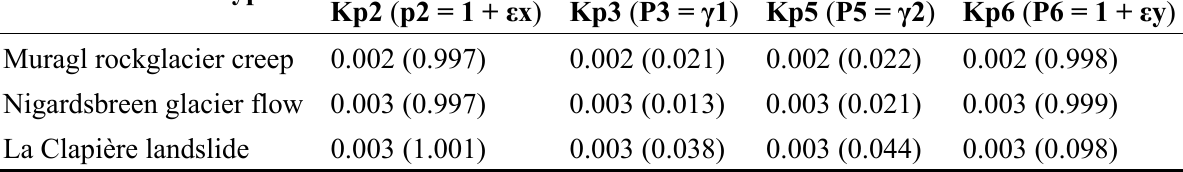
Table 8. Precision of the geometric (shape and size) parameters of the spatial transformation model for the three mass movement